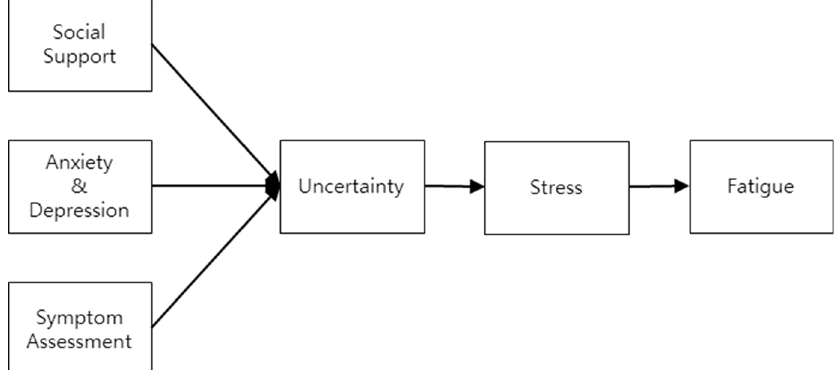
Figure 1. Conceptual framework.